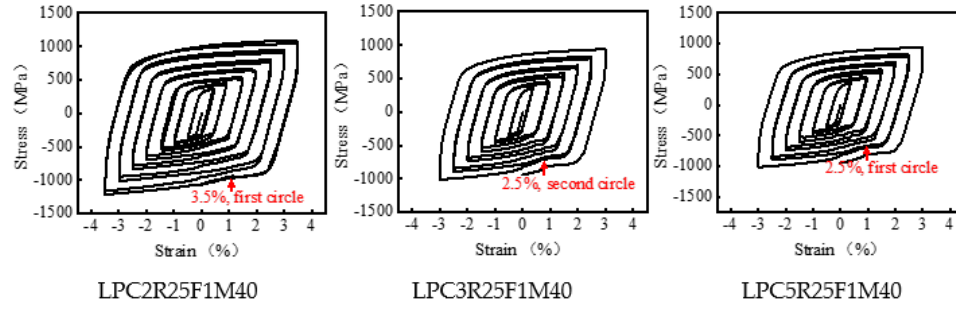
Figure 8. Hysteretic response curves of the proposed LPBRBs. All the parameters of three models are the same but for the clearance, thus the dif- ference among three models mainly depends on the contact force demand of the LP core. Obviously, the larger the gap, the greater the contact force between the LP core and the re- straining member, under the same axial compressive force. When the contact force demand exceeds the capacity of the outer tube in resisting the local bulging with the increasing axial load, local instability of the LPBRBs will occur. As seen in Table 4, the DCRs of the LPBRBs with local instability are all greater than 1.0, which means the local buckling failure can be well predicted by the Equation